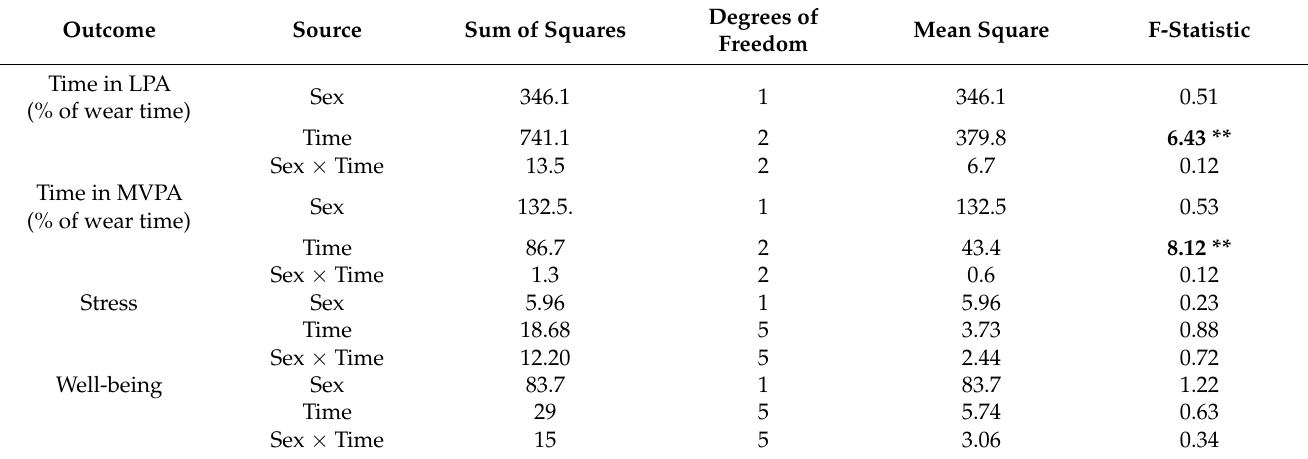
Table 5. Analysis of variance table for each of the targeted